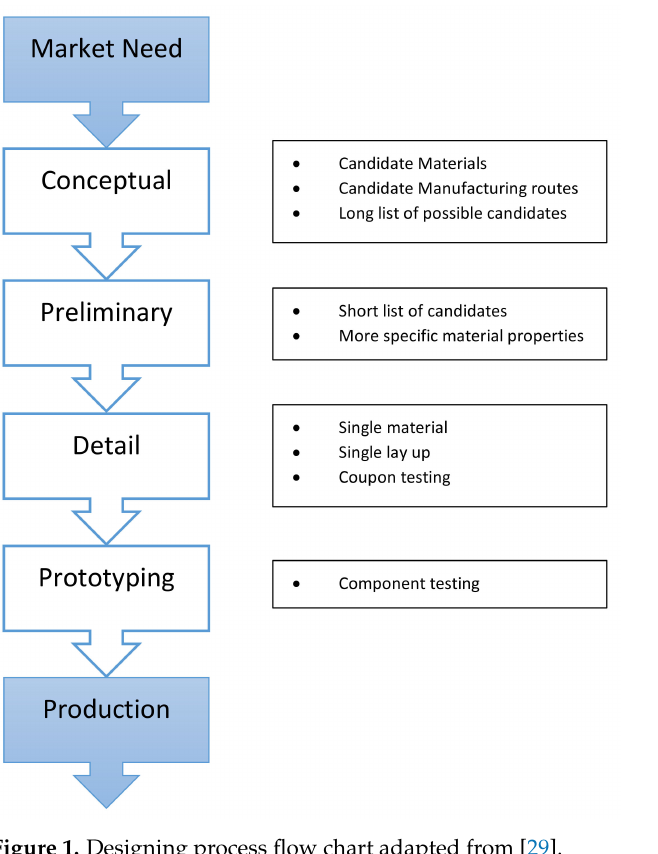
Figure 1. Designing process flow chart adapted from [29].